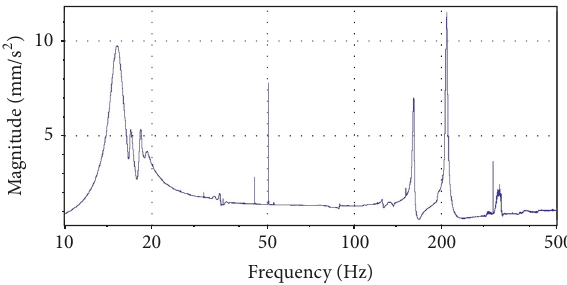
Figure 9: Frequency response characteristics of the